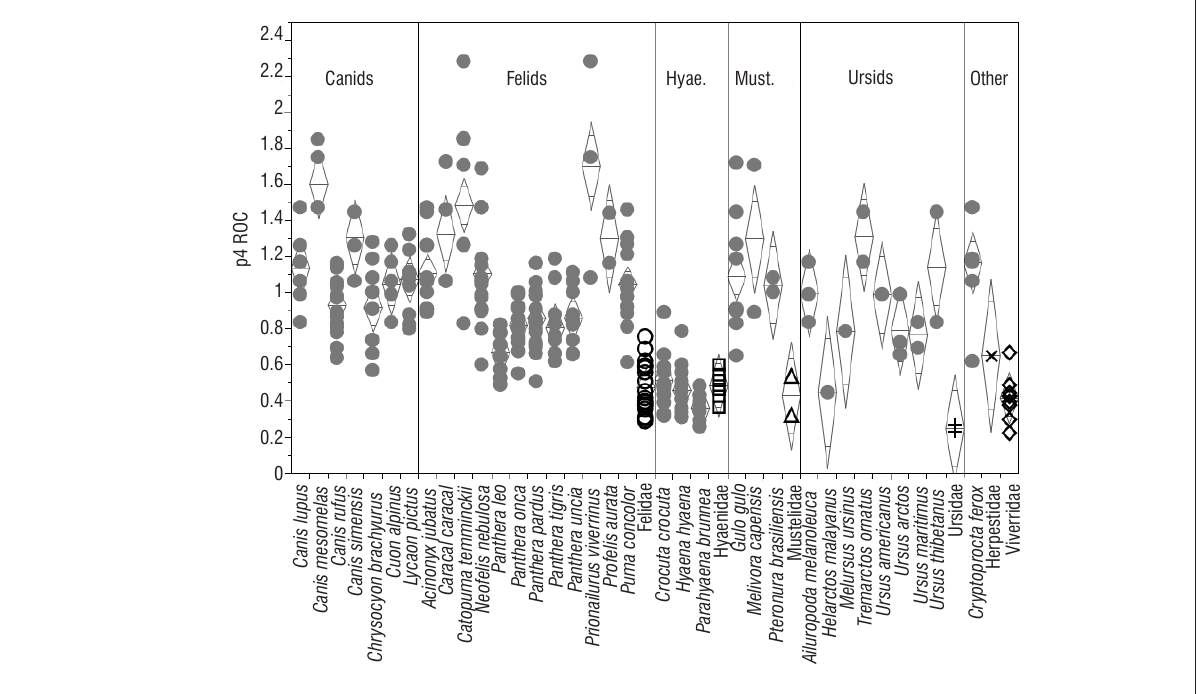
Extant taxa are represented by solid grey circles, Langebaanweg (LBW) felids by open circles, LBW hyaenids by open squares, LBW mustelids by open triangles, LBW ursids ( Agriotherium ) by ‘+’ signs, the single analysed LBW herpestid by an ‘x’ sign, and LBW viverrids by open diamonds. Each dotted diamond represents the mean and 95% confidence interval vertical span; the horizontal lines are the mean and ‘overlap marks’ that indicate statistical separation. Figure 5: Radii-of-curvature (ROC) score of the fourth (p4) lower premolars by species.